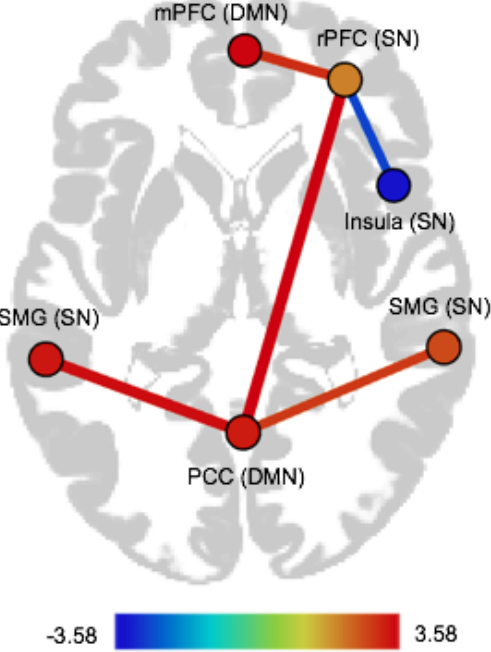
Figure 2. Illustration of ROI-to-ROI FC associated with CTQ neglect. mPFC = medial prefrontal cortex, rPFC = rostral prefrontal cortex, SMG = supramarginal gyrus, PCC = precuneus cortex, SN = salience network, DMN = default mode network.